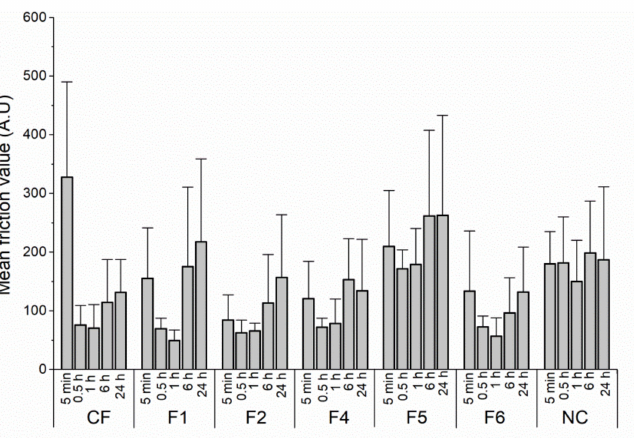
Figure 4. The changes in mean friction value on skin areas treated with developed film-forming systems and non-treated control over 24